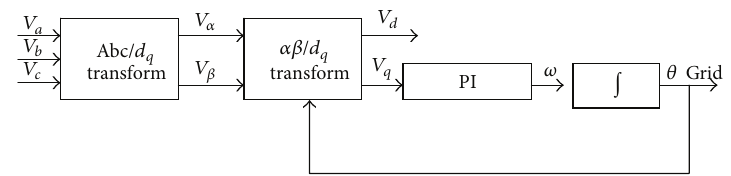
Figure 3: Transport delay-based PLL algorithm.